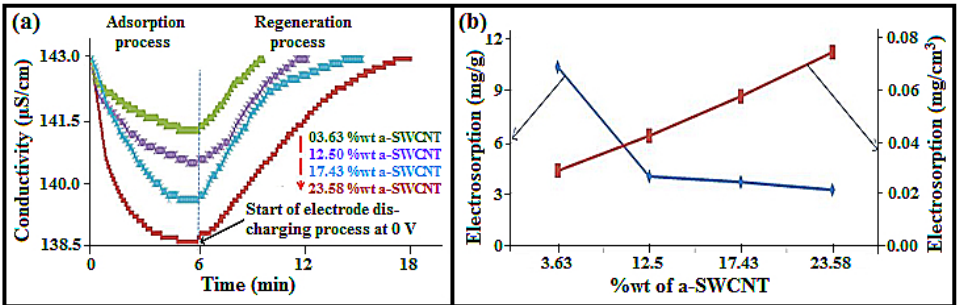
Figure 9. ( a ) Adsorption and release behaviour; and ( b ) the electrosorption capacity in terms of the mass of a-SWCNT and the geometric volume of the electrode at various a-SWCNT-coated RVC electrode coatings of a-SWCNT (wt%): 3.63%, 12.50%, 17.43%, and 23.58%.